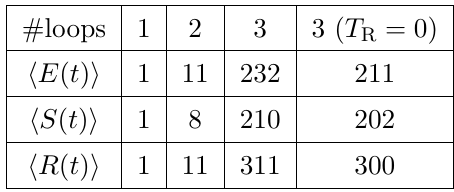
E ( t ) at one loop (a); a two-loop diagram for h i R ( t ) (f). h i